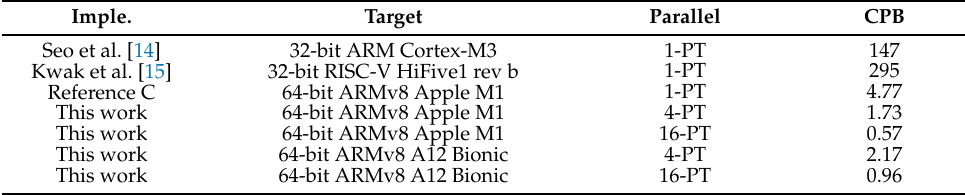
Table 2. Performance comparison of implementation of the ARIA block